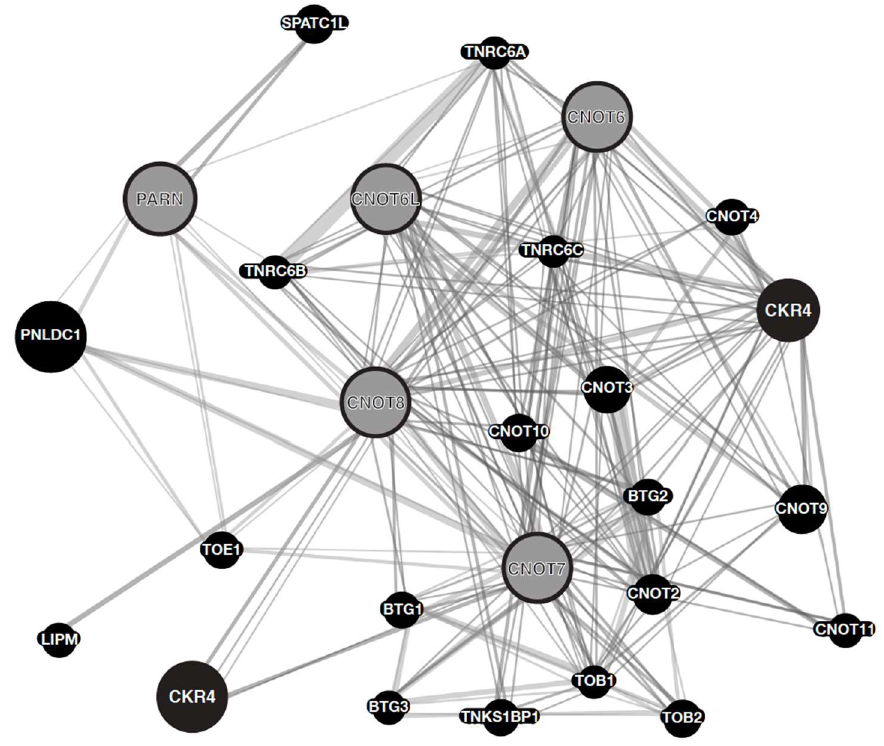
Figure 1. Genetic association network for CNOT6, CNOT6L CNOT7, CNOT8, PARN deadenylases. The genetic network shows the most frequent neighboring genes. Every gene is represented as a node (query genes are in grey color). Genes are linked by associated networks that include co-expression, physical contact, co-localization, genetic interactions, pathways, and shared protein domains. Lines represent the abovementioned different interactions between the gene nodes.